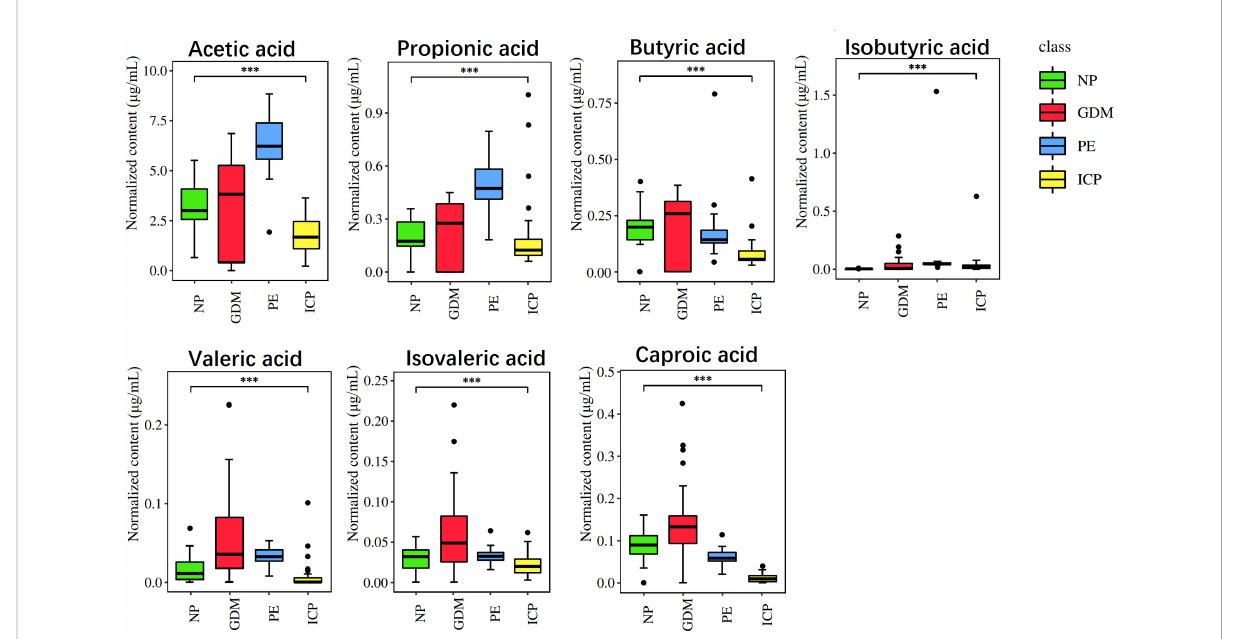
FIGURE 4 Quantitative analysis of SCFAs in pregnancy complications and NP groups. The abscissa is different groups, the ordinate is the content of short chain fatty acids, and different colors represent different groups. ***P <